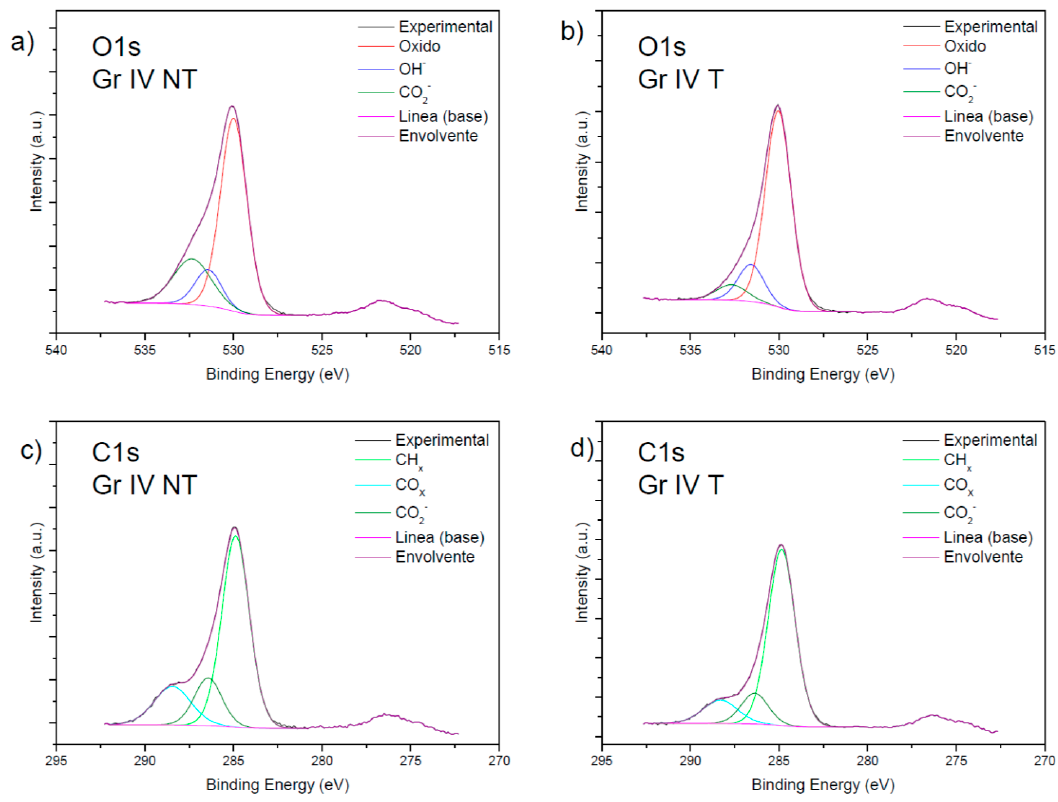
Figure 3. O 1s X-ray photoelectron spectroscopy (XPS) spectra of the untreated grade IV ( a ) and the treated grade IV surfaces ( b ). C1s spectra of the untreated grade IV ( c ), and the treated grade IV ( d ) surfaces. (GR IV: Titanium grade IV; GR V: Titanium grade V; T: SLA treated; NT: SLA non-treated).